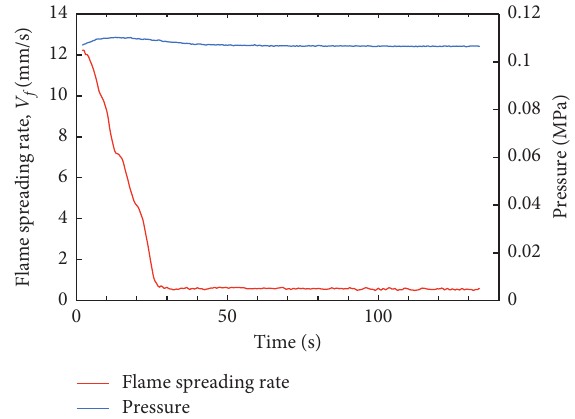
Figure 7: Pressure and flame spreading rate histories (Test 6).